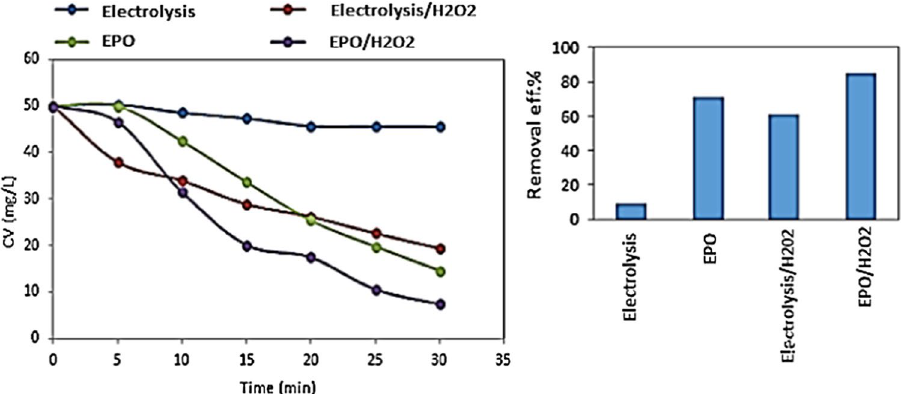
Fig. 2 Effect of electrolysis and its combinations with ozonation and peroxone on CV decol- orization [condition: reactor volume 500 cc and 70 rpm, applied current 0.1 A, NaCl 100 mg/L, unadjusted pH, ini- tial CV concentration 50 mg/L, ozone 2 mg/L. min and H 2 O 2 15